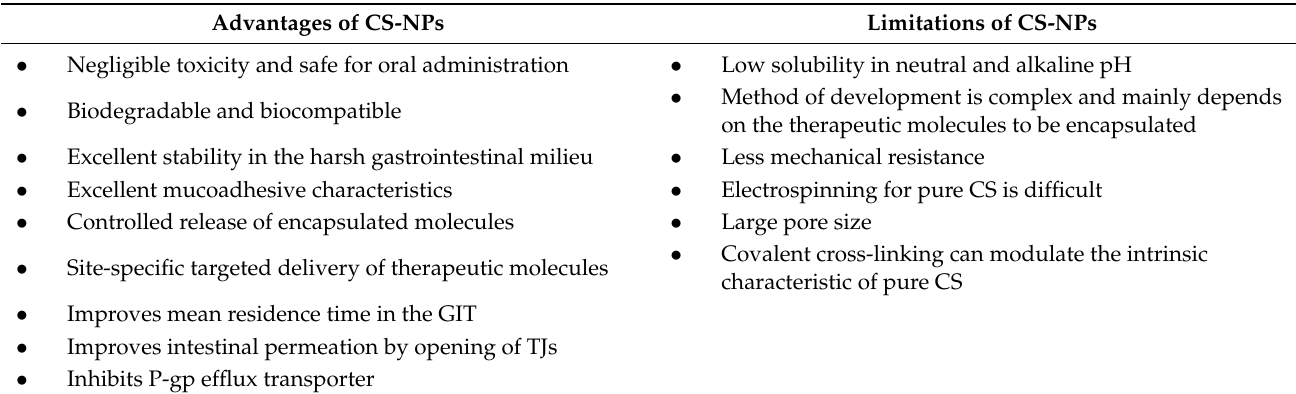
Table 3. Advantages and limitations of CS-NPs over other NP-based systems for oral delivery of phytochemicals [71]. Advantages of